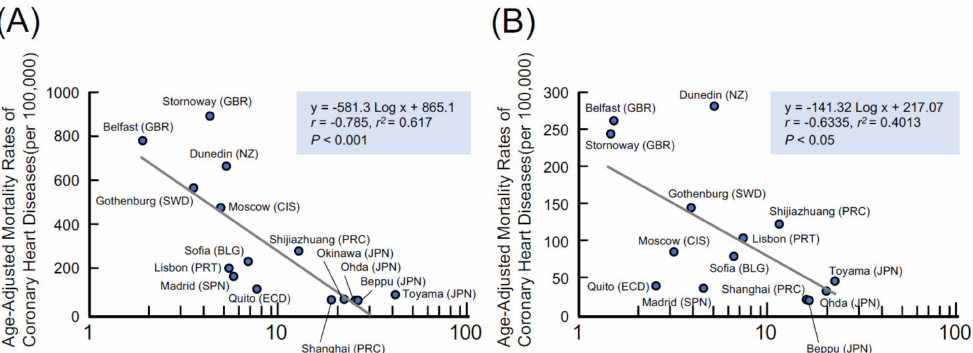
Figure 4. Relationship between 24 h urinary excretion of isoflavones and age-adjusted coronary heart disease mortality rates in men ( A ) and women ( B ). Modified data from a study [42] are